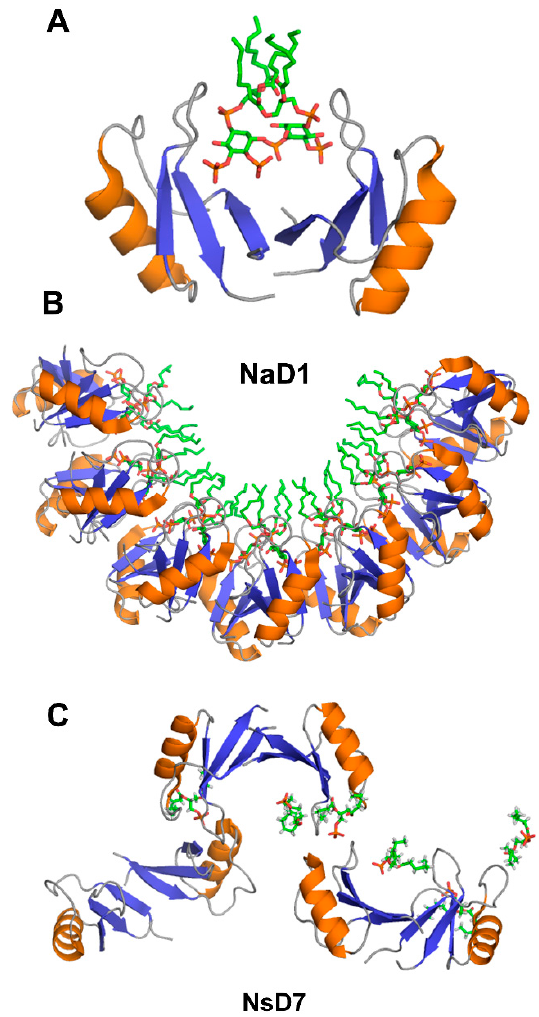
Figure 5. Three-dimensional structures of plant defensins in complex with phospholipids. ( A ) NaD1 defensin dimer forms a “catioinic grip” to bind phosphatidylinositol 4,5-bisphosphate (PIP 2 ) (PDB